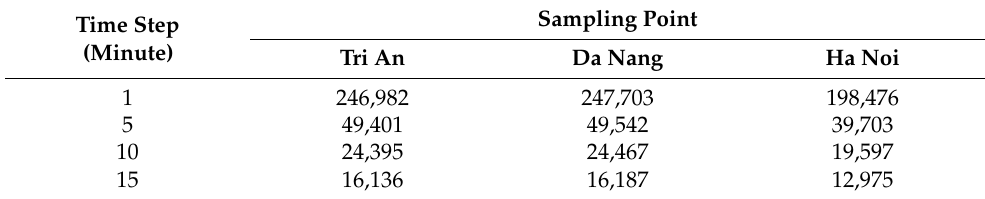
Table 5. The sample size of measurements in different time steps for three regions in